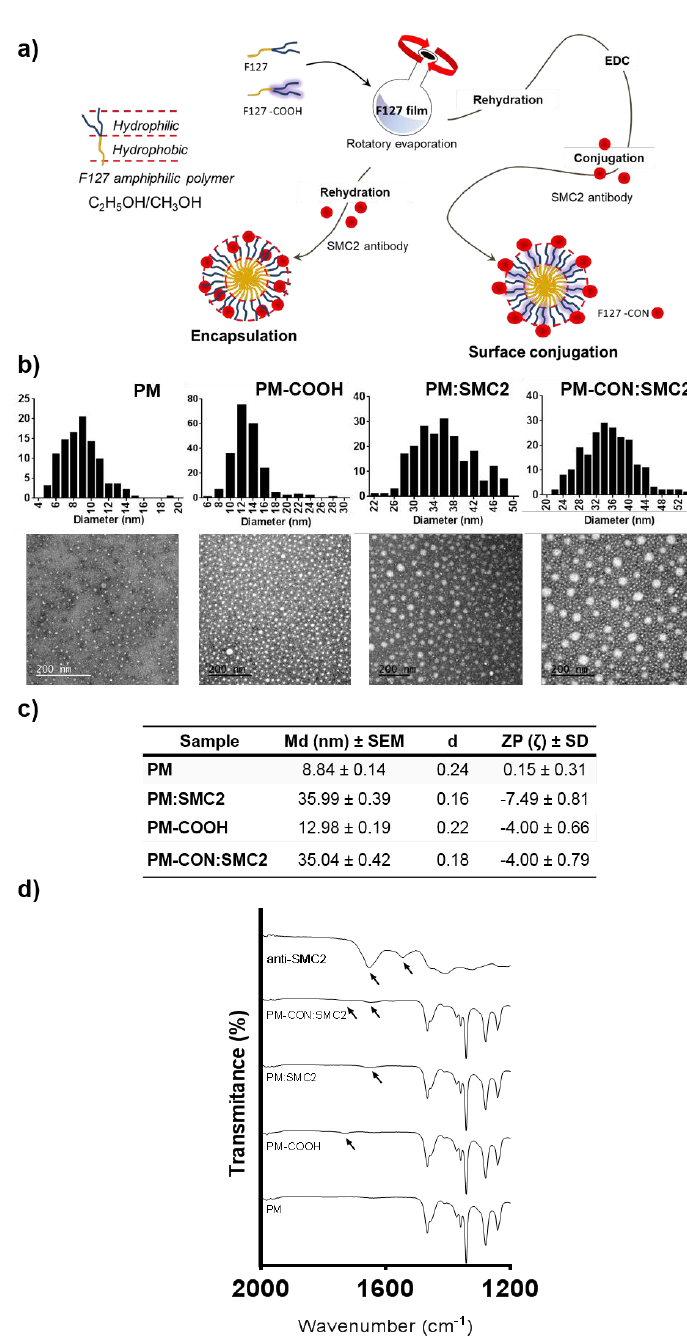
Figure 2. PM-Ab-SMC2 characterization. ( a ) Schematic representation of the two strategies employed for PM synthesis loaded with anti SMC2 antibody, namely encapsulation and surface conjugation. ( b ) TEM micrographs of the four distinct PM formulations. The panels above the micrographs correspond to the size distribution of the particles obtained by TEM image analysis. Scale bar represents 200 nm. ( c ) Summary table of mean diameter (Md), Dispersity Index ( d ), Zeta Potential (ZP) and ( d ) FTIR spectra, displaying the appearance of a peak at 1646 cm − 1 and corresponding to amide I bond formation.